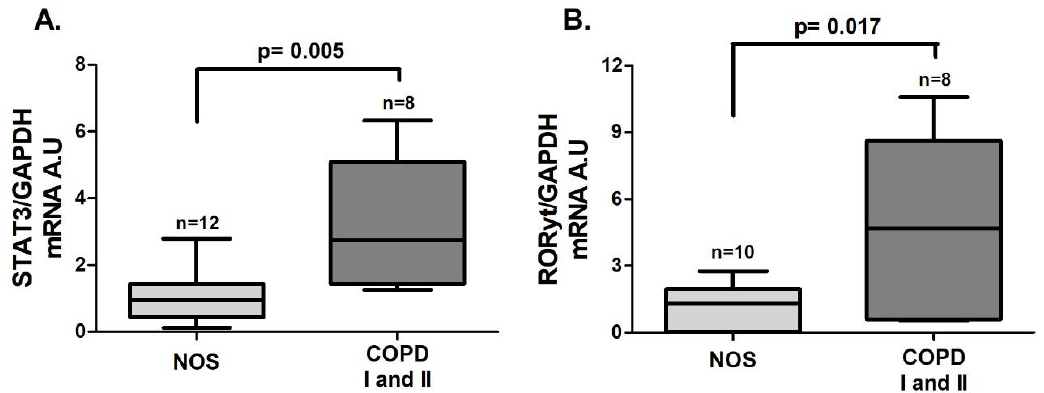
Figure 1. Th17 transcription factors in lung tissue samples. Th17 transcription factors gene expression in lung tissue samples: ( A ) increased STAT3 gene expression ( p = 0.005, t -test) in the COPD I and II group; ( B ) increased ROR γ t gene expression ( p = 0.017, t -test) in the COPD I and II group. The data are expressed as the median and interquartile range. A.U: Arbitrary Units.